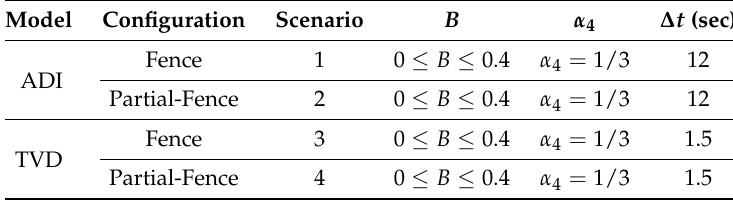
Table 1. Scenarios simulated and initial parameters